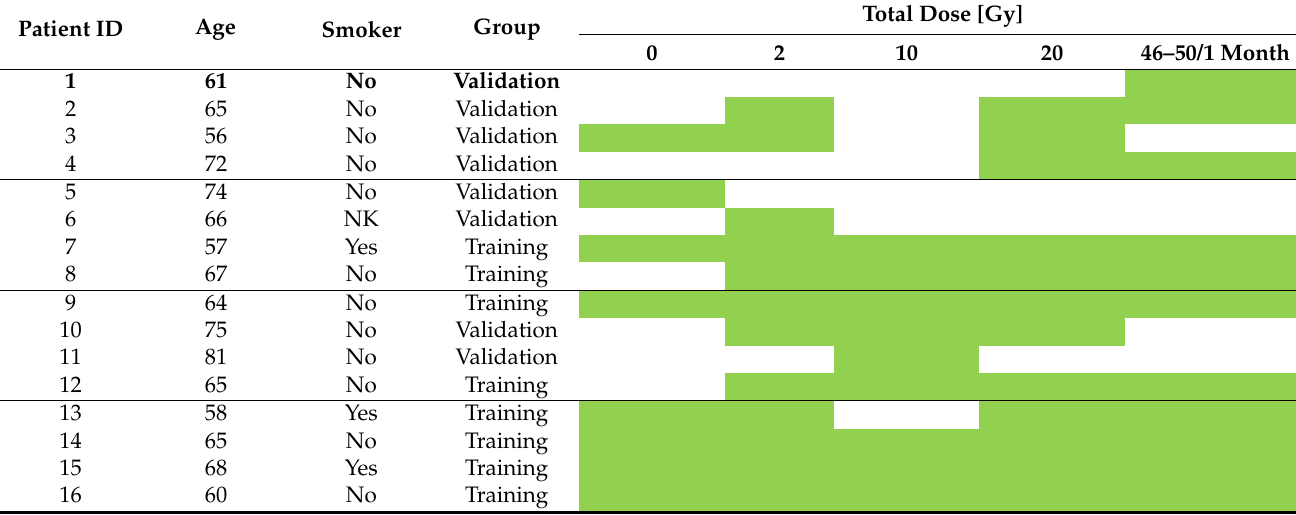
Table 1. Description of patients and samples used in the study. The group column shows which patient sample sets were used in the training or validation cohort. The total dose column shows the doses (given in 2 Gy fractions over five days per week) received by the patients after which miRNA expression could (green colour) or could not (no colour) be measured. Sampling was performed on the day when an accumulated dose of 2, 10, and 20 Gy, and one (1) month after the full dose of 46 or 50 Gy, was reached.